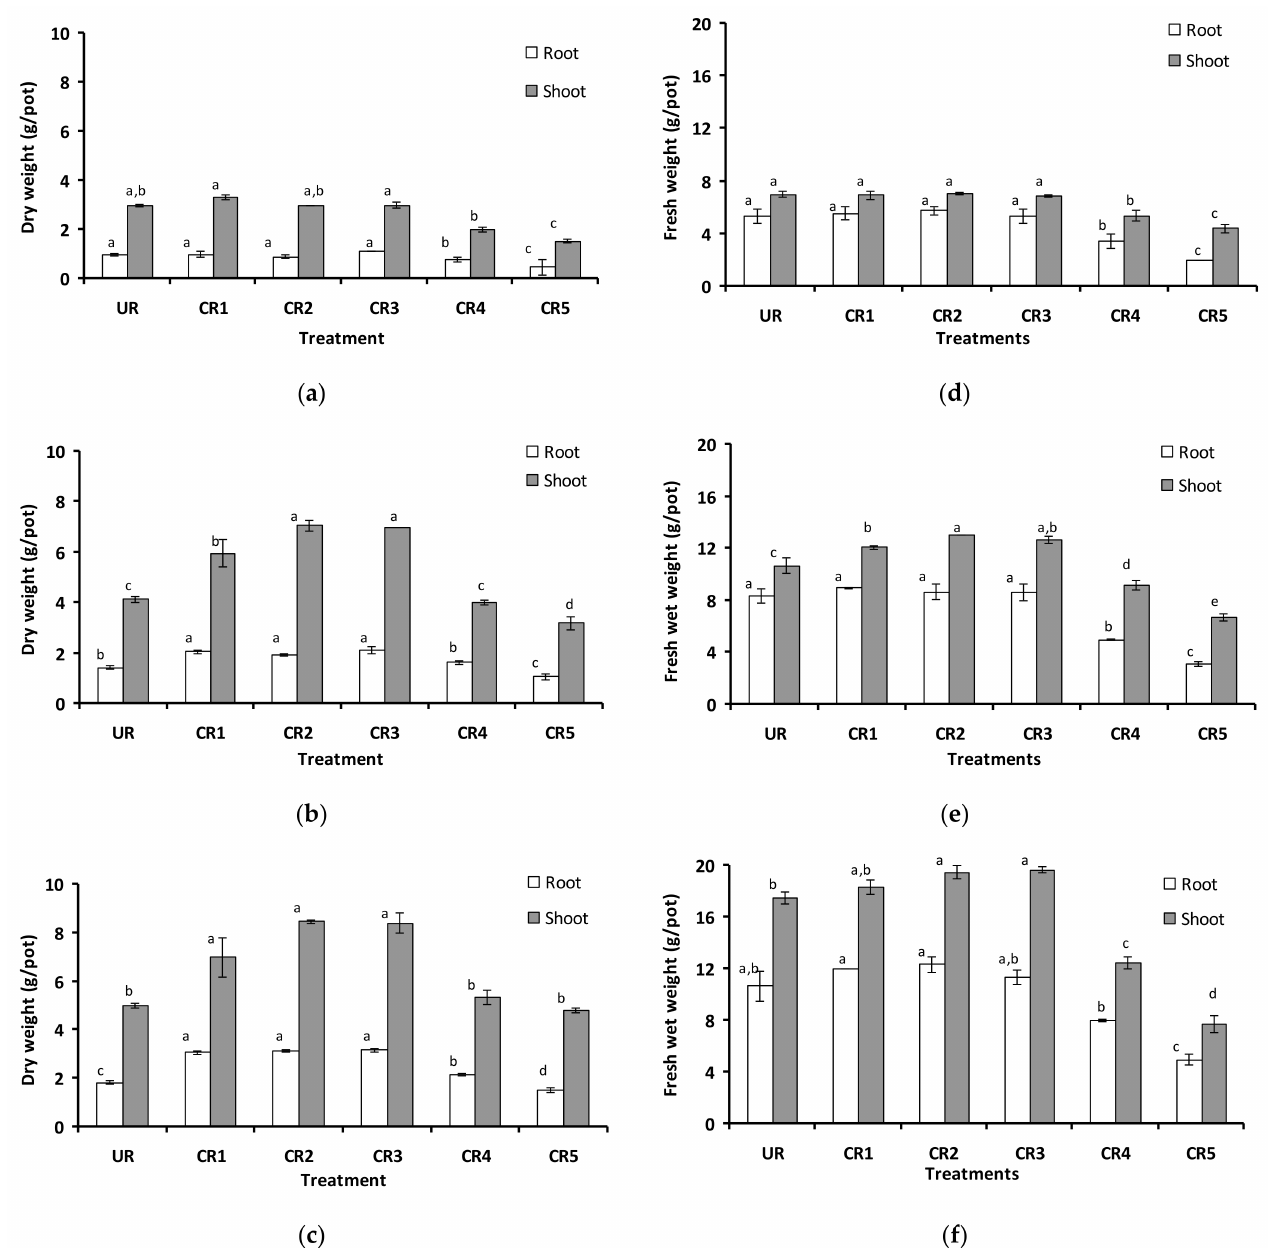
Figure 4. Effects of POS after 30, 60, and 90 days of plant growth to the dry ( a – c ) and fresh weight ( d – f ) biomass of C. cajan , respectively. Different letters to C. cajan root and shoot organs are significantly different based on Tukey post hoc analysis ( p < 0.05). Bars represent means ± standard deviation ( n = 3). UR is an uncontaminated rhizosphere and CR 1 to CR5 represent contaminated rhizosphere with POS from 1 to 5% w / w